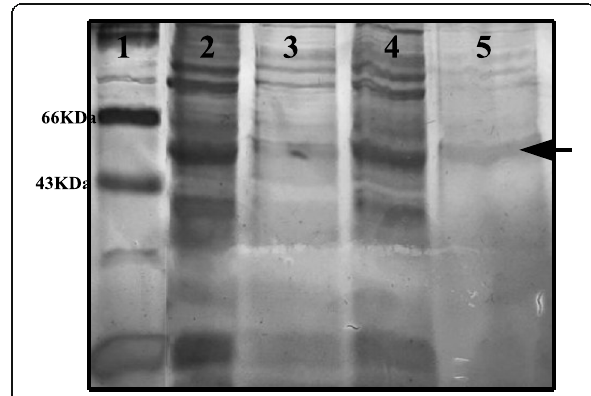
Fig. 6 Protein profile of partially purified (metal affinity purification) recombinant cellulase on SDS-PAGE. Lane 1, protein marker; lane 2, supernatant of cell lysate; lane 3, flow through of supernatant; lane 4, wash fraction; lane 5, elution fraction (250 mM imidazole) with arrow showing cellulase band